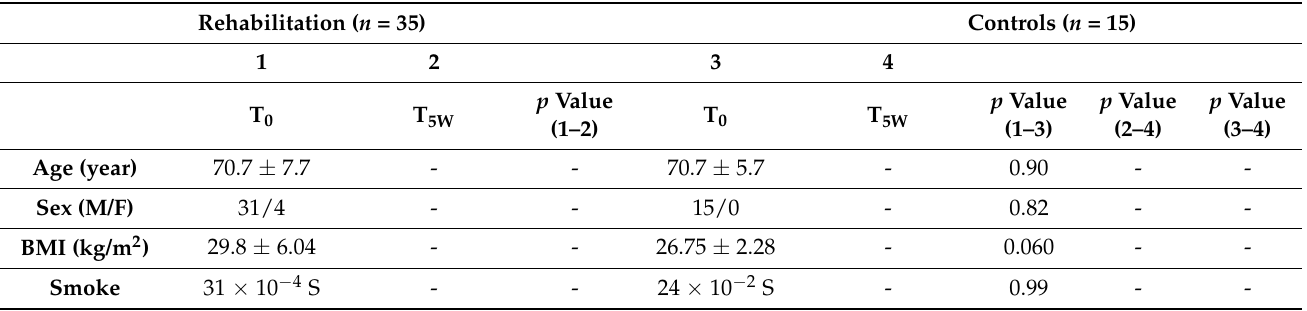
Table 1. Clinical characteristics of COPD patients under PR and controls at the baseline (T 0 ) and after 5 weeks (T 5W